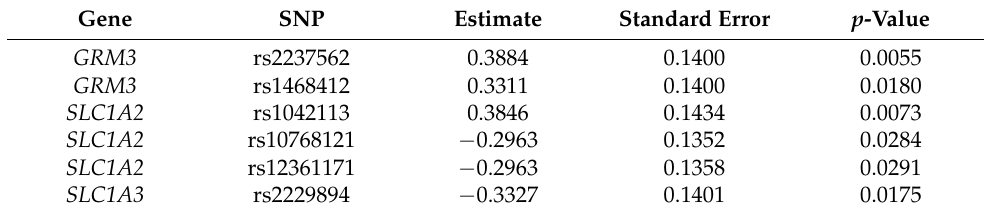
Table 4. Results of regression analysis of association between genetic markers and tardive dyskinesia. Gene SNP Estimate Standard Error GRM3